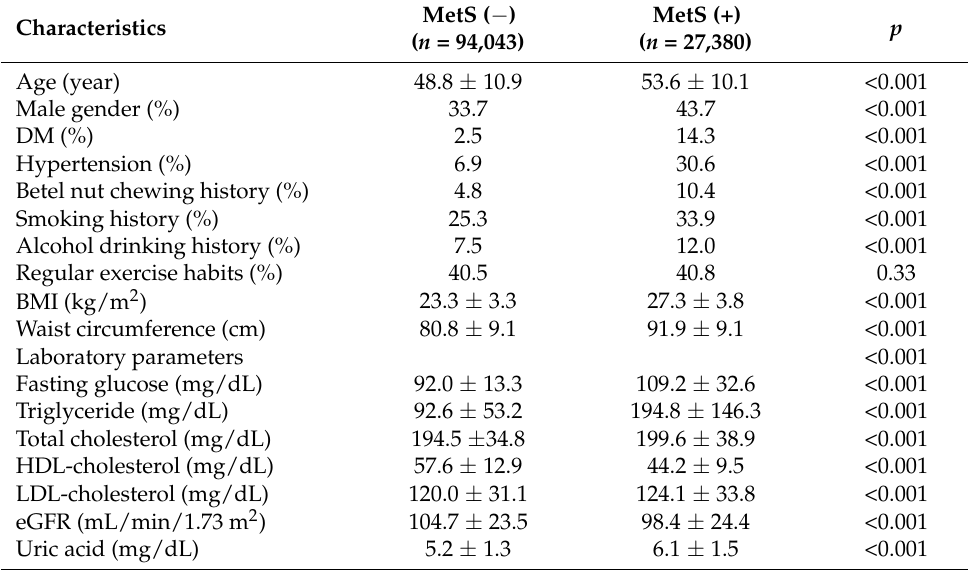
Table 1. Comparison of clinical characteristics among participants according to baseline